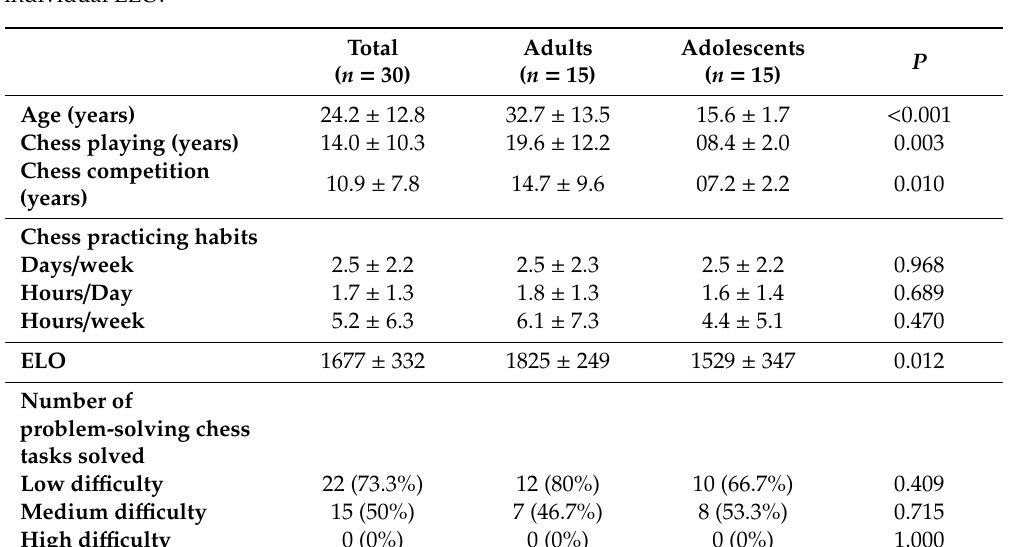
Characterization of the participants according to age, chess practicing habits, and individual